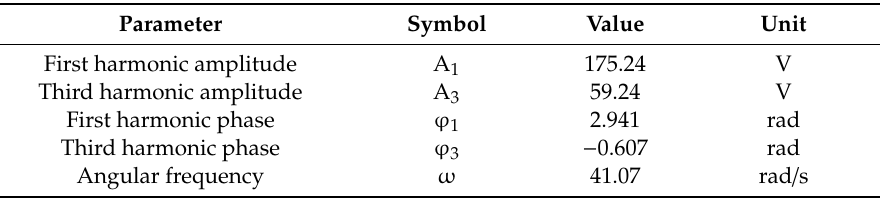
Table 2. Fourier approximation of no-load voltages produced by